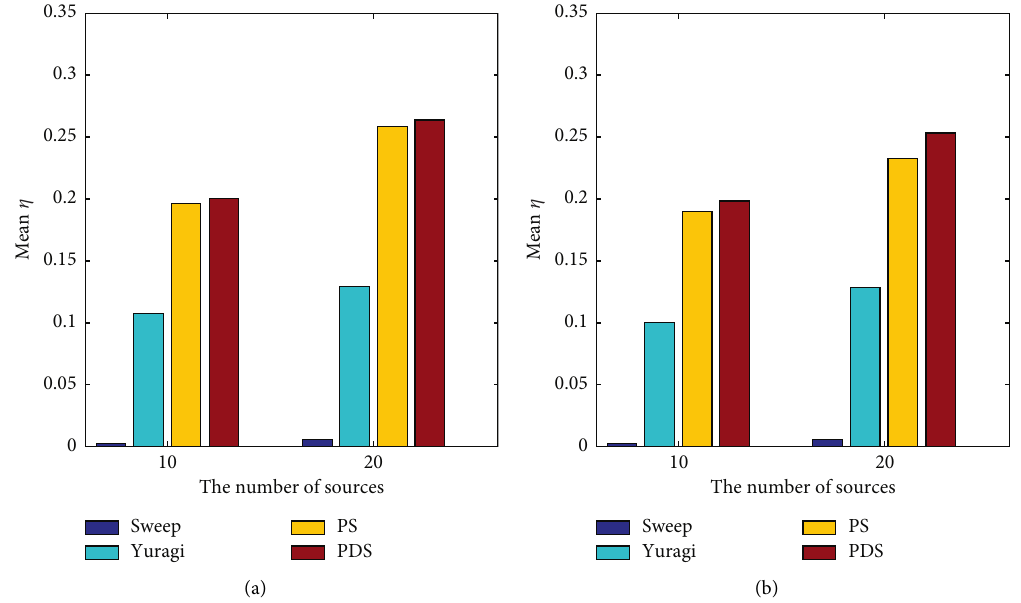
Figure 12: For different central field intensities, comparison of η for four algorithms. Blue, cyan, yellow, and red bars represent the η for the sweep, Yuragi, PS, and PDS, respectively. (a) The sources with the Gaussian-like shape field intensity distribution. (b) The light